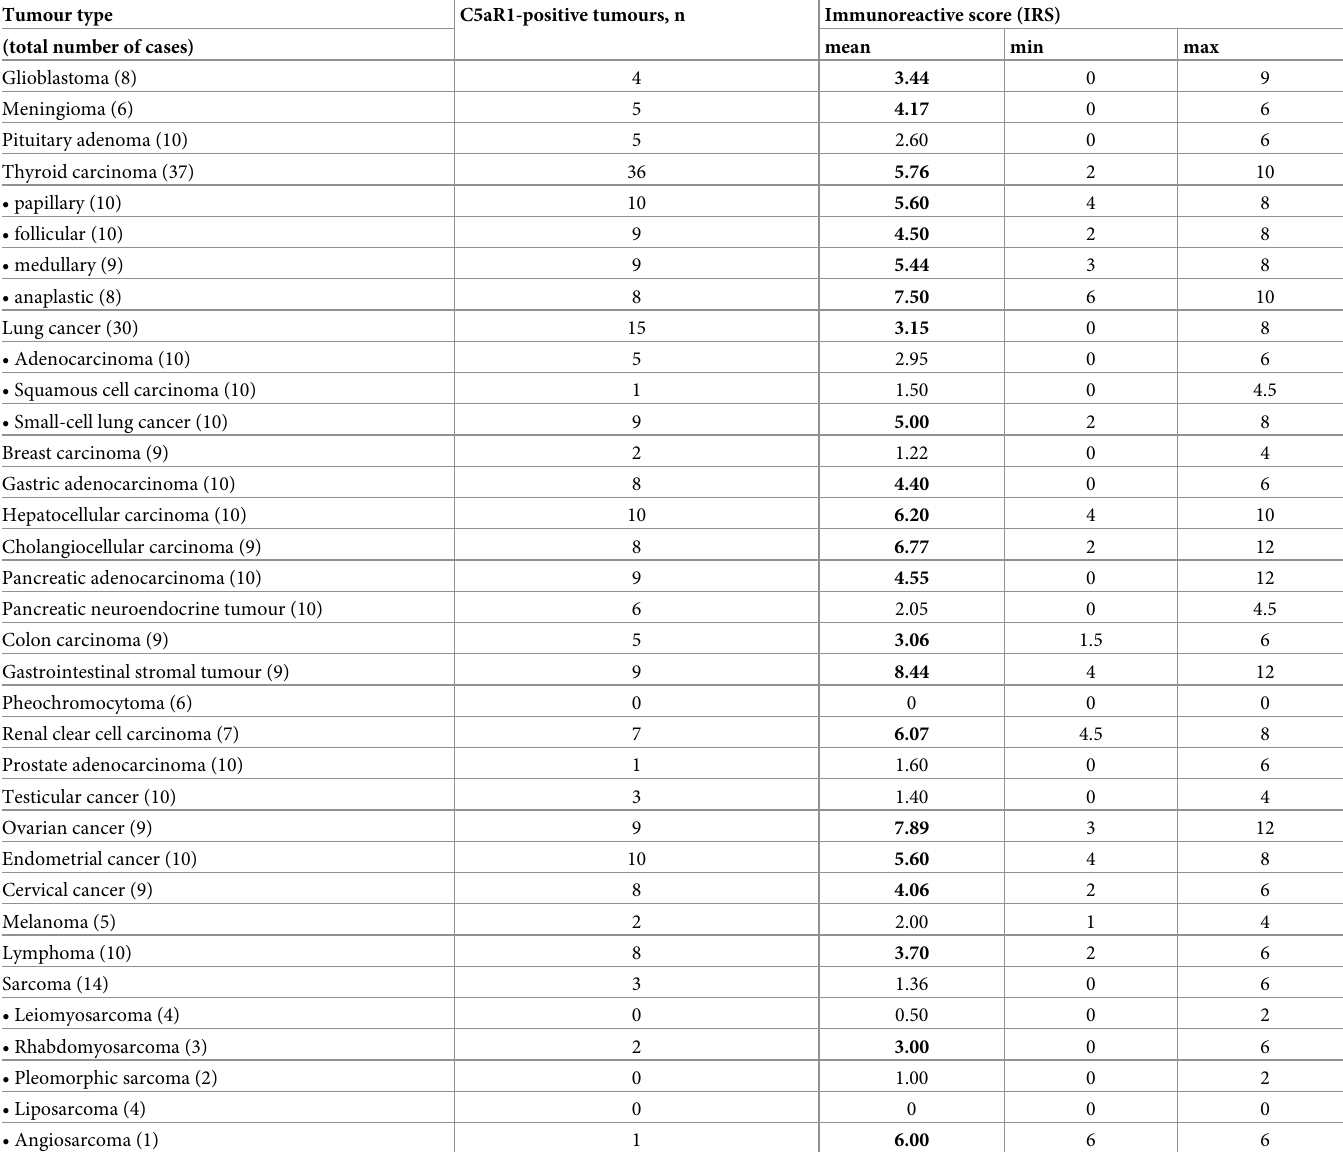
Table 1. Presence of C5aR1 in the tumour cells of different tumour